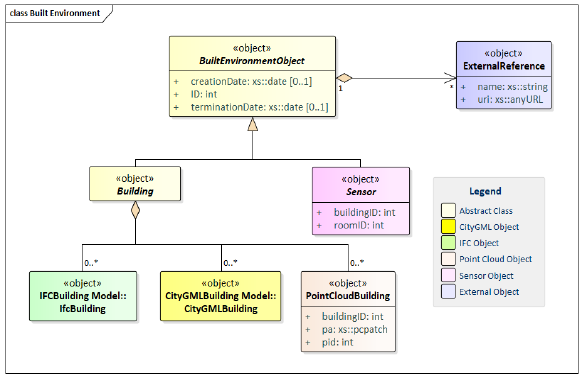
Figure 4. Conceptual design of unified building